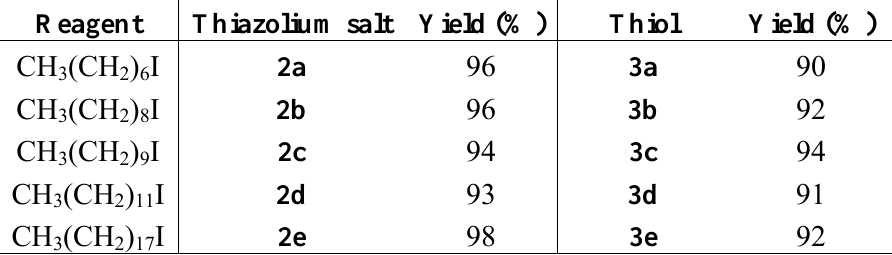
Table 1. Isolated yields in thiazolium iodides and